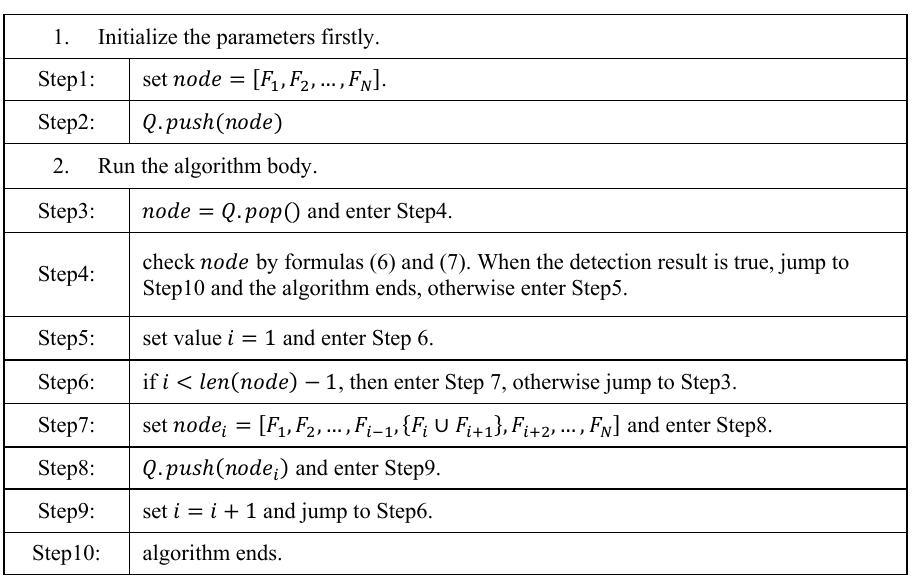
Table 1. Interference resource allocation